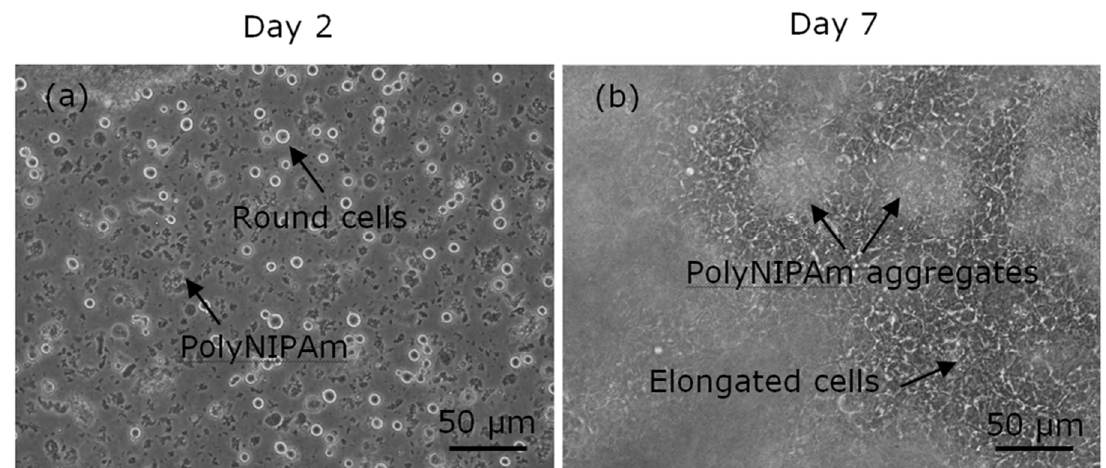
Figure 10. Optical micrographs of HEK cells suspension containing polyNIPAm microspheres produced using a thermal initiator (T1), on ( a ) Day 2 and ( b ) Day 7 of the culturing process.